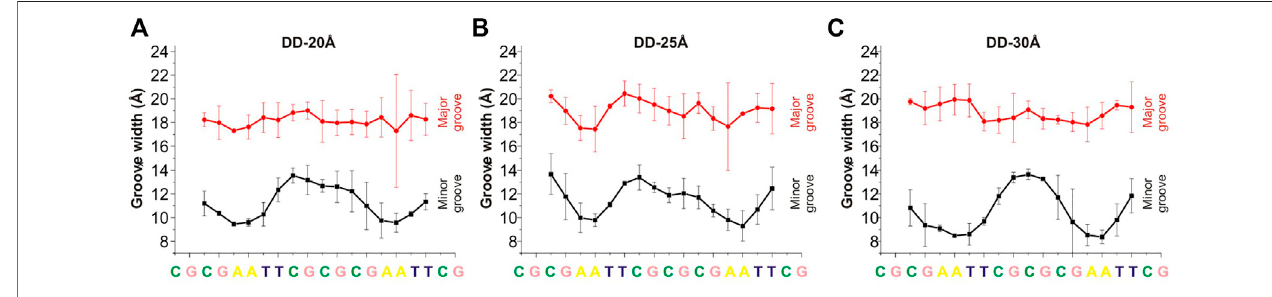
FIGURE4| Widthoftheminor and majorgrooves foreach basepair, in (A) DD-20 Å, (B) DD-25 Å, (C) DD-30 Å.Thevaluesofthegroove widthareaveragedover two DNA duplexes. The widths of the grooves for DNA1 and DNA2 are shown in Supplementary Figure S7 .